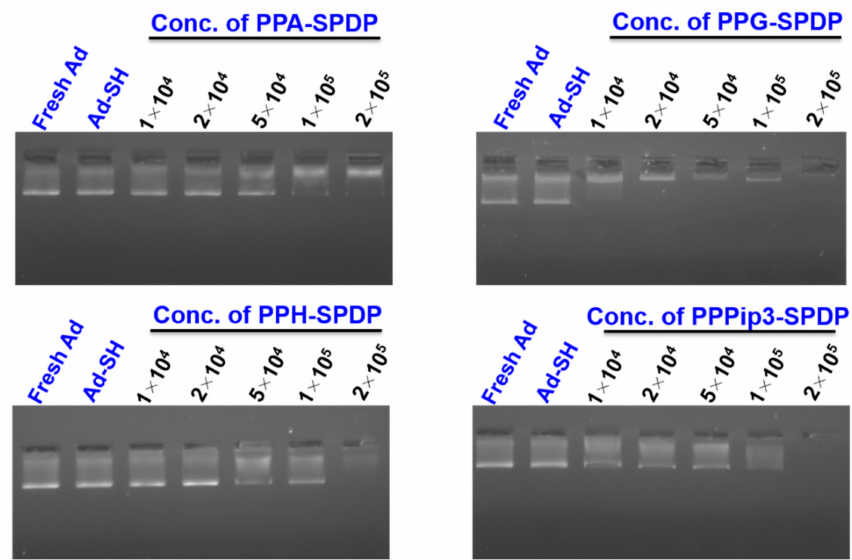
Figure 8. Gel retardation assay of PPA-Ad, PPH-Ad, PPG-Ad, and PPPip3-Ad conjugates prepared at various molar ratios of copolymers (1 × 10 4 , 2 × 10 4 , 5 × 10 4 , 1 × 10 5 , or 2 × 10 5 ). Fresh Ad and Ad-SH were also used to confirm the effective covering of Ad capsids.